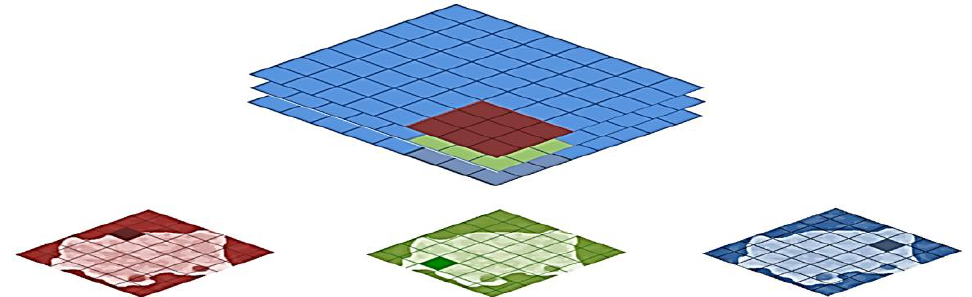
Figure 8. Xception used the depth-wise convolution to split the image by using a 3 × 3 filter linked to 1 × 1 point-wise convolutions to build a linear convolution.